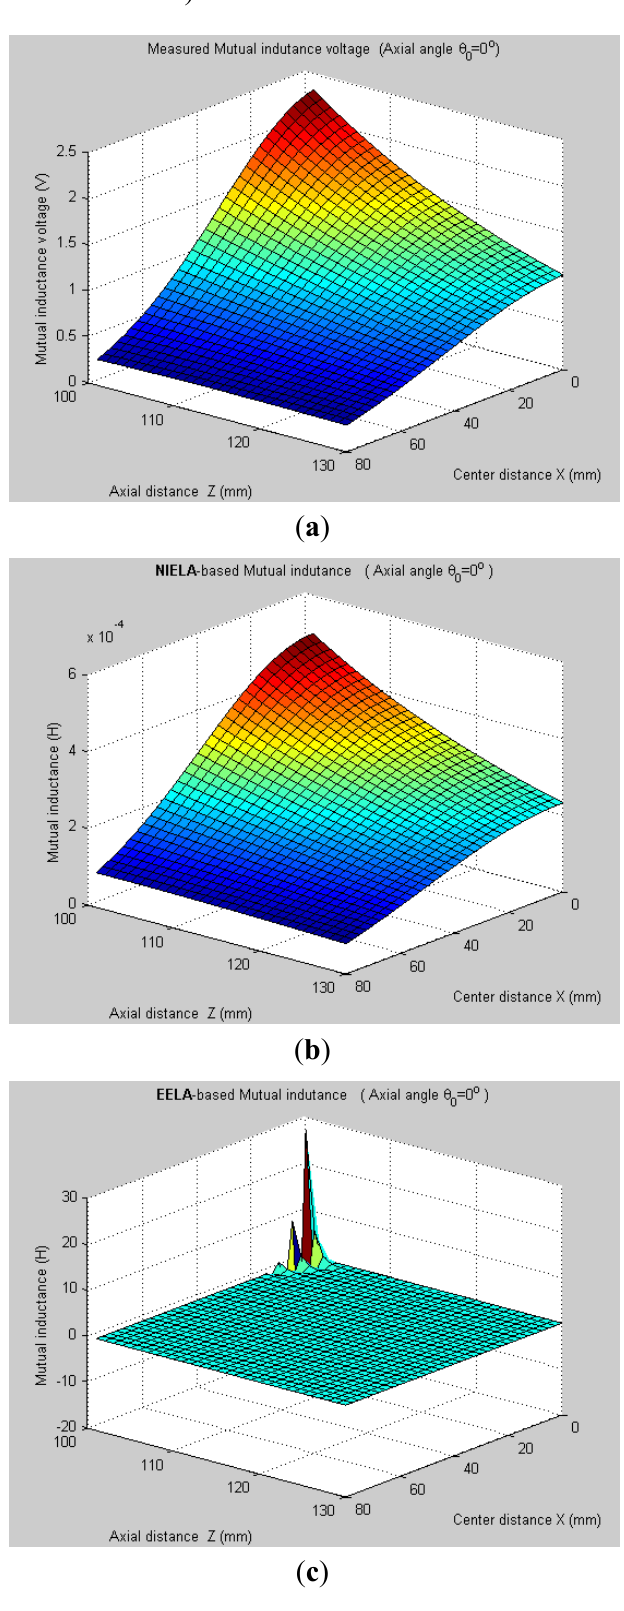
Figure 7. 3-D graphs of ( a ) measured mutual inductance voltage; ( b ) NIELA -based mutual inductance; ( c ) EELA -based mutual inductance versus axial distance and center = 0°, Z = 101–130 distance ( θ 0